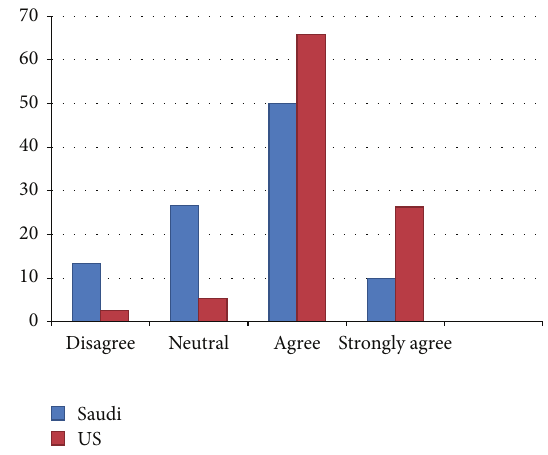
Figure 1: The response was mostly negative when Saudi residents were asked if the residency program adequately prepared them for the written and oral board